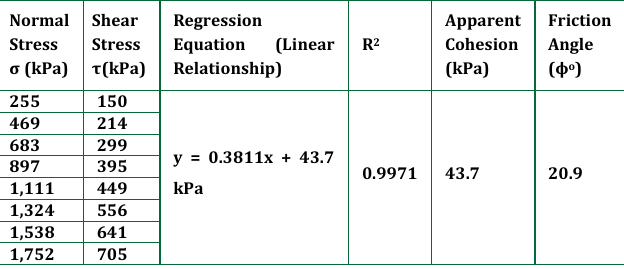
Figure 2: Polished sandstone surface - One way shearing with increasing normal stress